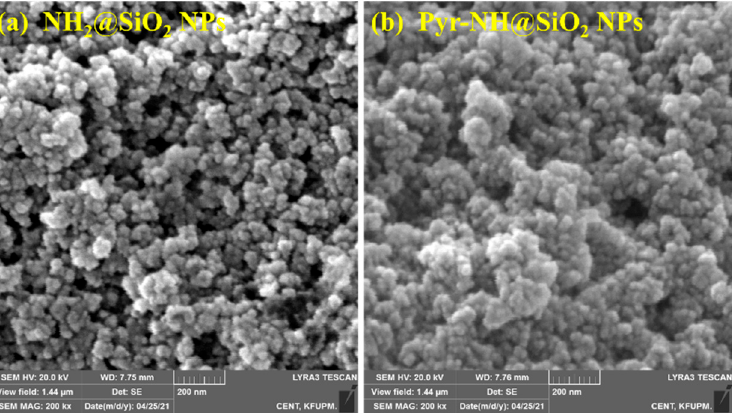
Figure 2. High-resolution FESEM images of ( a ) NH 2 @SiO 2 NPs and ( b ) Pyr-NH@SiO 2 NPs. Considering the attachment of organic components with silica NPs, the thermal sta- bility of amino-functionalized silica (NH 2 @SiO 2 NPs) and pyrene-functionalized silica (Pyr-NH@SiO 2 NPs) was investigated from room temperature to 800 °C (Figure 3). The first weight loss (~10%) was observed up to 160 °C due to moisture and water molecules that are physically adsorbed on the surface of silica NPs. The weight loss (~21.8%) detected in the region from 160 °C to 800 °C for NH 2 @SiO 2 NPs is mainly due to the thermal de- composition of 3-aminopropyl and silanol groups [39], which confirm the chemical at- tachment of 3-aminopropyl groups with silica NPs. However, in the case of Pyr-NH@SiO 2 NPs, the weight loss was observed in two consecutive steps. In the first step, the weight loss (40.9%) between 160 °C to 400 °C is attributed to the organic components attached to silica while the weight loss (14.5%) between 400 °C to 600 °C is mainly due to the thermal decomposition of organosilicate frameworks (Si–C, C–N, and C–C bonds) [28,40]. The ob- served weight losses also confirm the attachment of pyrene dye with silica NPs. The re- sults indicate that the developed sensor having Pyr-NH@SiO 2 NPs is thermally stable enough (up to 200 °C) for practical applications. Figure 3. Thermogravimetric curves of ( – ) NH 2 @SiO 2 NPs and ( – ) Pyr-NH@SiO 2 NPs show the thermal decomposition of organic components and organosilicate frameworks attached to silica nanoparticles. The surface area and pore structure of NH 2 @SiO 2 NPs and Pyr-NH@SiO 2 NPs were assessed by nitrogen adsorption-desorption isotherms. The curves (Figure 4) represent type II isotherms at high relative pressure, which suggests the formation of macroporous silica materials having uniform size distributions [11]. The obtained parameters, such as BET surface area (S BET ), total pore volume (V), and average pore diameter (D BJH ), are sum- marized in Table 1. The comparison indicates that the BET surface area of NH 2 @SiO 2 NPs (116.2 m 2 g − 1 ) decreases 2.61 times as compared to Pyr-NH@SiO 2 NPs (44.5 m 2 g − 1 ). More- over, the values of Barrett-Joyner-Halenda (BJH) pore sizes for synthesized NH 2 @SiO 2 NPs and Pyr-NH@SiO 2 NPs were found to be 30.8 nm and 25.3 nm, respectively. This decrease in surface area, pore size, and pore volume of Pyr-NH@SiO 2 NPs signifies the blocking of pore surfaces and channel walls, which also confirms the presence of a fluorescence indicator (pyrene) on the inner surface of silica